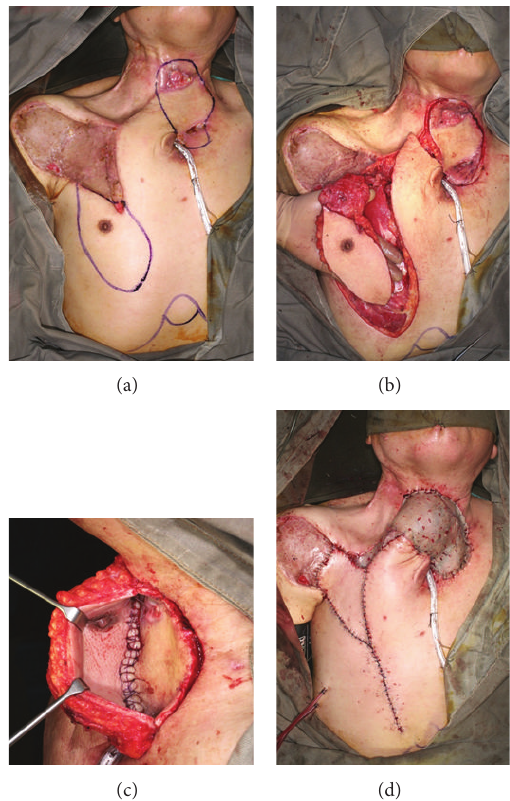
Figure 3: (a) Total laryngectomy and circumferential pharyngectomy defect in a patient unfit for free flap reconstruction. Posterior pharyngeal wall previously reconstructed with DP flap. (b) DP flap divided. Edges of neopharyngeal wall mobilized. Pectoralis major (PM) flap raised for anterior pharyngeal wall reconstruction. (c) Neopharynx reconstructed with divided DP flap as posterior wall and PM flap as anterior wall. (d) Undersurface of PM flap covered with skin graft. Base of previous DP flap used to protect anastomosis and prevent salivary spillage into the tracheostomy in case of leakage. Axillary flap was also raised to cover the chest wall defect in this